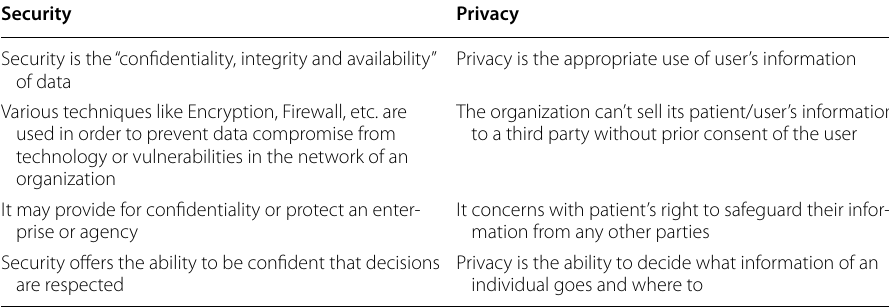
Table 1 Differentiation between security and privacy Security